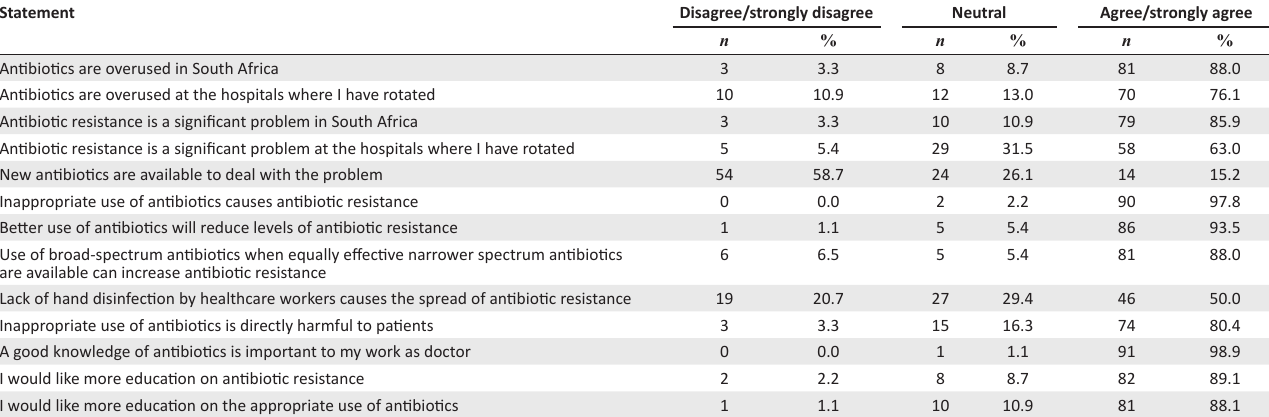
TABLE 1: Summary of the respondents’ perceptions regarding antibiotic prescribing. Statement